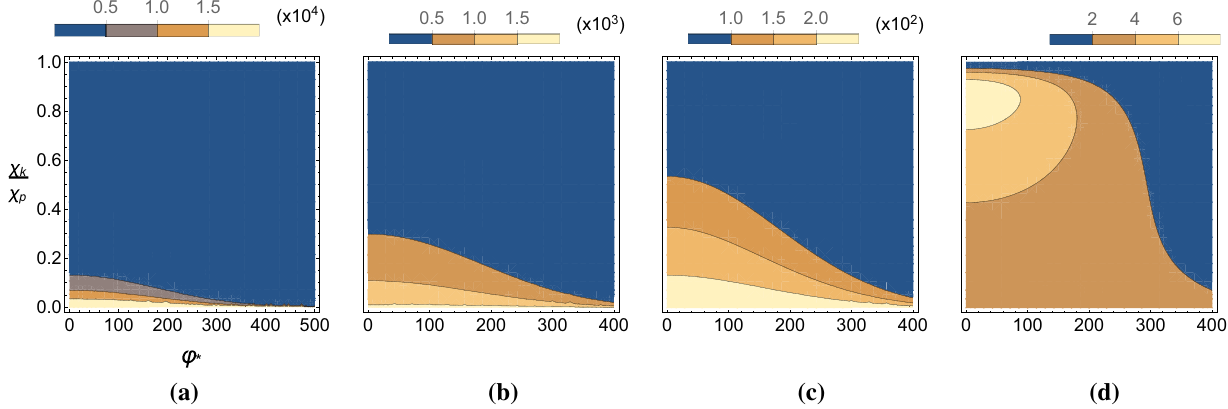
Fig. 7 The scalar yield, P + , is plotted as a function of χ k /χ p and the phase ϕ ∗ in a Gaussian background with a pulse duration of 100 fs and m φ = 0. a χ p , 0 = 0 . 1, b χ p , 0 = 0 . 4, c χ p , 0 = 1, d χ p , 0 = 10